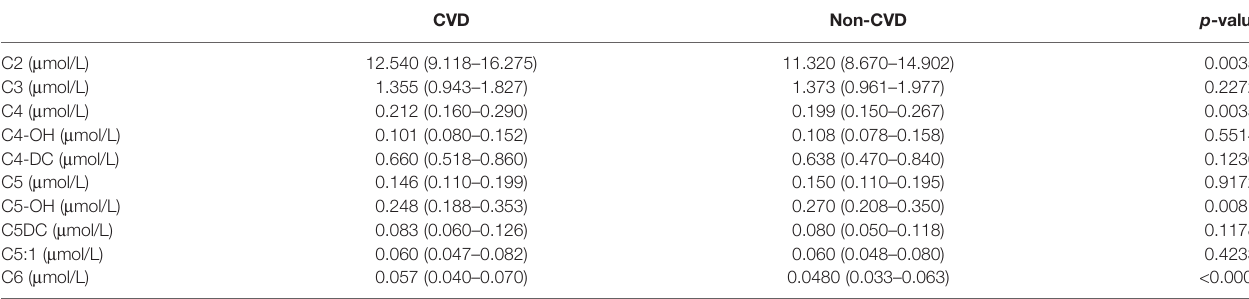
TABLE 2 | Short-chain acylcarnitine levels betweenT2DM patients with CVD and T2DM patients without